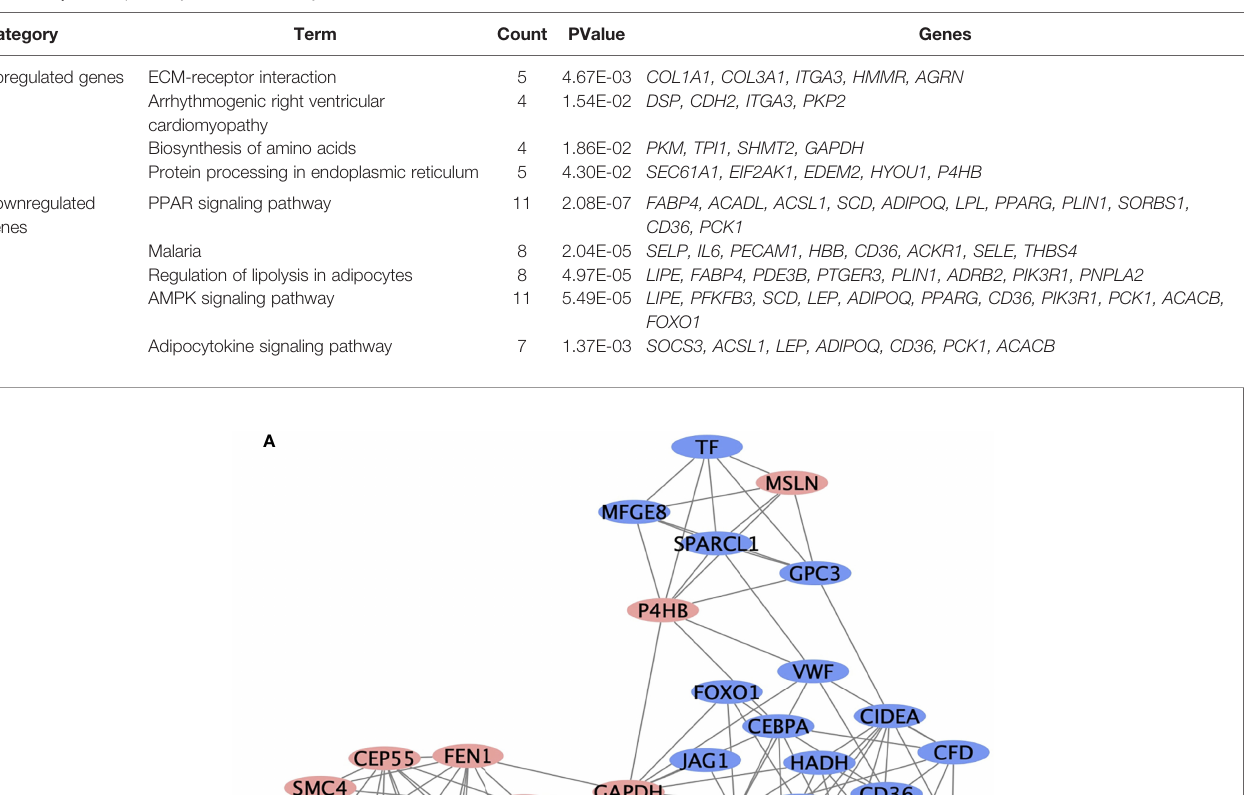
TABLE 2 | KEGG pathway enrichment analysis of DEGs.